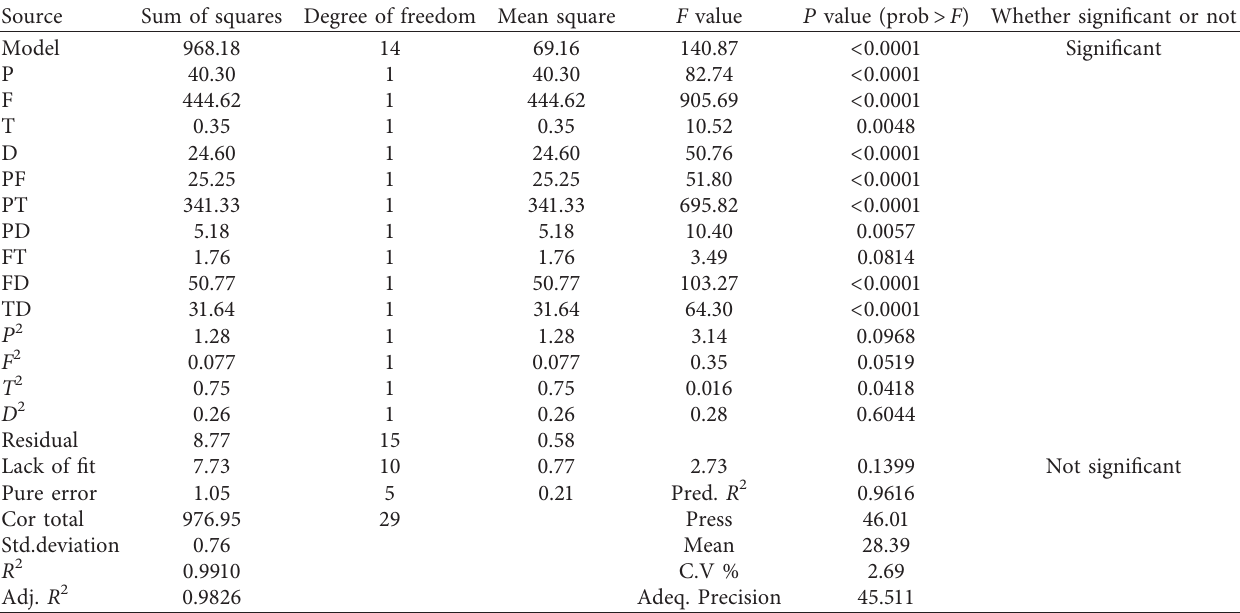
Table 5: ANOVA test results for weight loss of the